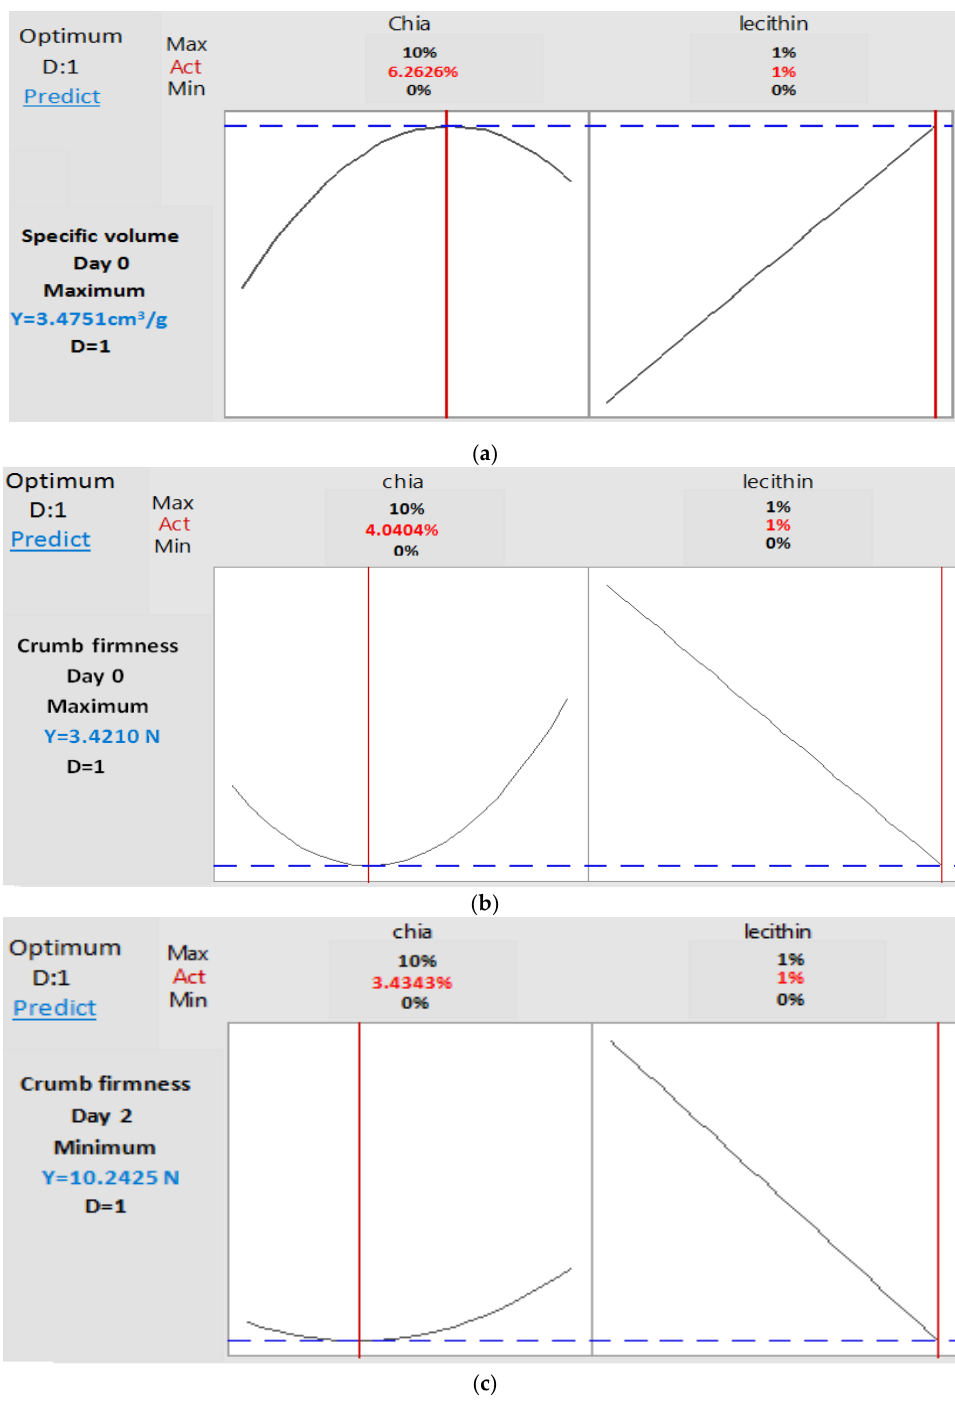
Figure 6. Optimized doses of chia and lecithin in order to maximize bread specific volume at day 0 ( a ), or minimize crumb firmness at day 0 ( b ) or minimize crumb firmness at day 2 ( c ). D, Desirability; Act, Action; Predict, prediction of the of the optimum